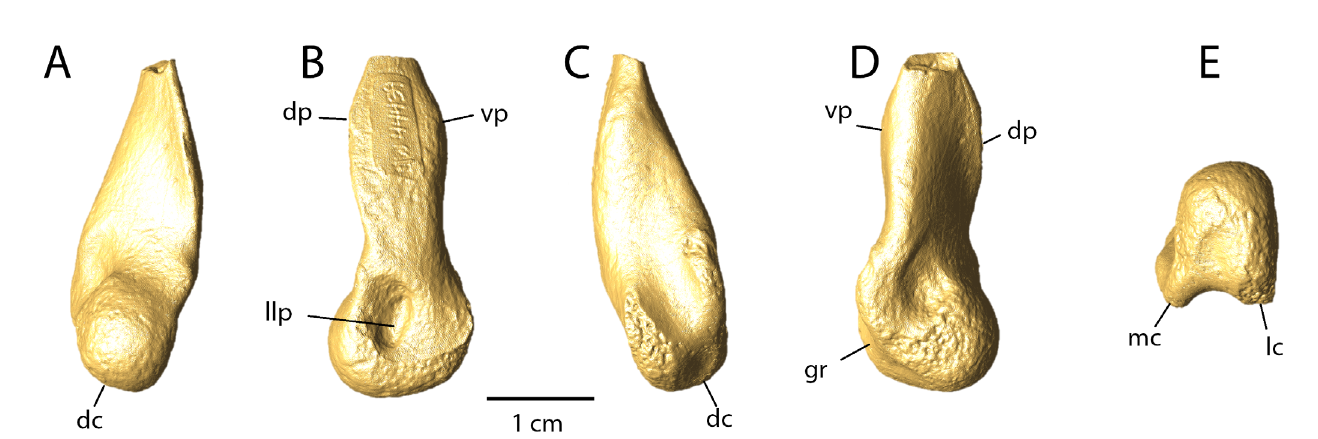
Figure 2. 3D model of UW 44439, a left metatarsal I of Caenagnathidae indet., in A, dorsal view; B, lateral view; C, ventral view; D, medial view; E, distal view. Abbreviations: dc, distal condyle; dp, dorsal prominence; gr, groove; lc, lateral hemi- condyle; llp, lateral ligament pit; mc, medial hemicondyle; vp, ventral prominence. The model is courtesy of Collection of Fossil Vertebrates, Department of Geology and Geophysics of the University of